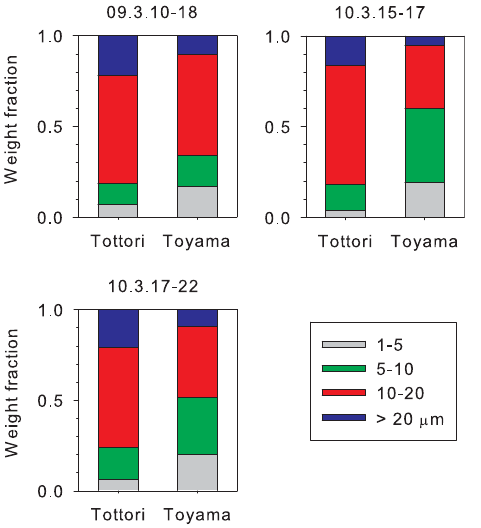
Fig. 8. Weight fraction of size-segregated refractory dust deposited by wet processes. Sampling periods are shown at the top of each panel as yy.mm.dd–dd.